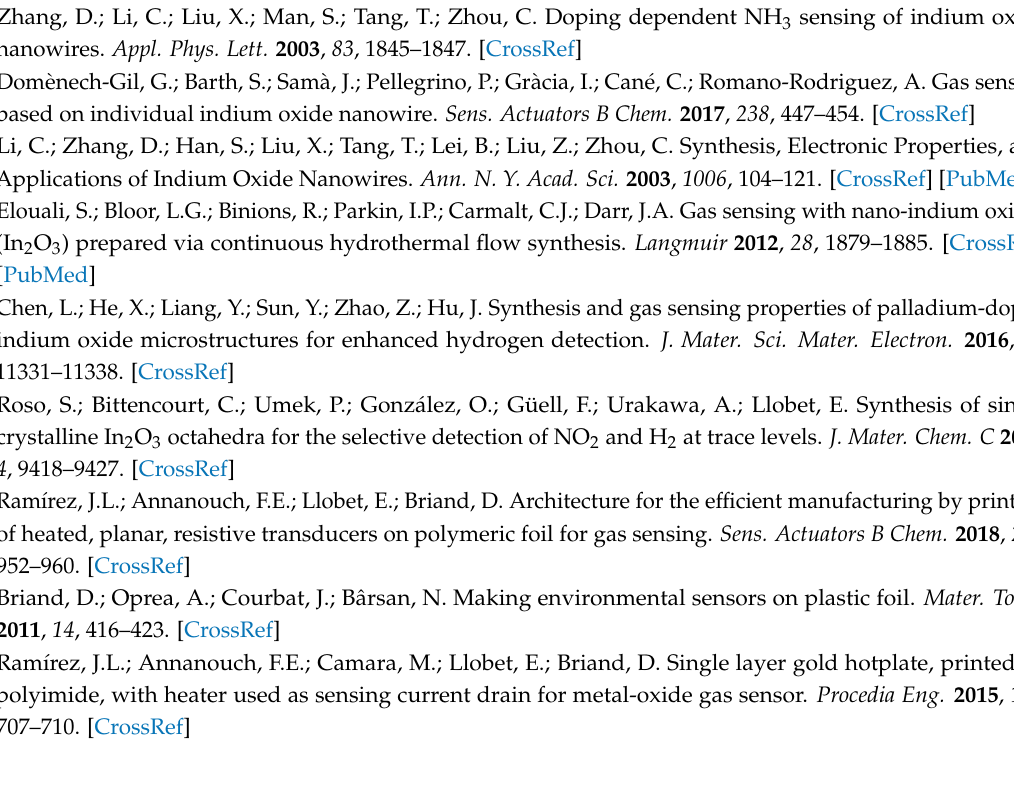
Figure S1. EDX from an In 2 O 3 sample synthesized at 400 ◦ C. Figure S2. EDX from an In 2 O 3 sample synthesized at 500 ◦ C sample. Figure S3. Nitrogen dioxide calibration curves for a sensor consisting of indium oxide synthesized at 400 ◦ C coated onto a polyimide flexible transducer. Table S1. Comparison of gas-sensing performances of In 2 O 3 gas sensors using different